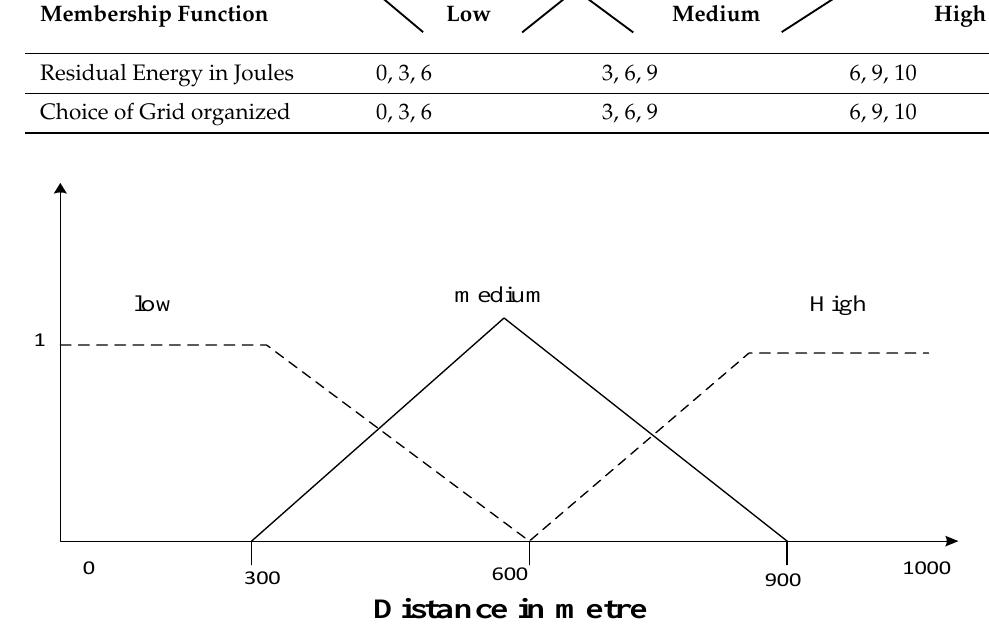
Figure 4. Membership function drawn for distance choice.